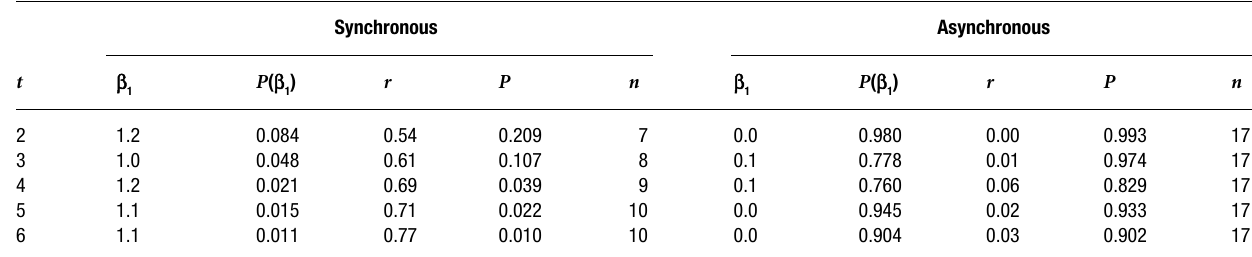
Table 2 | Signifi cance levels and correlation coeffi cients for the regression coeffi cient of the log-linear regression Eq. (1). Synchronous